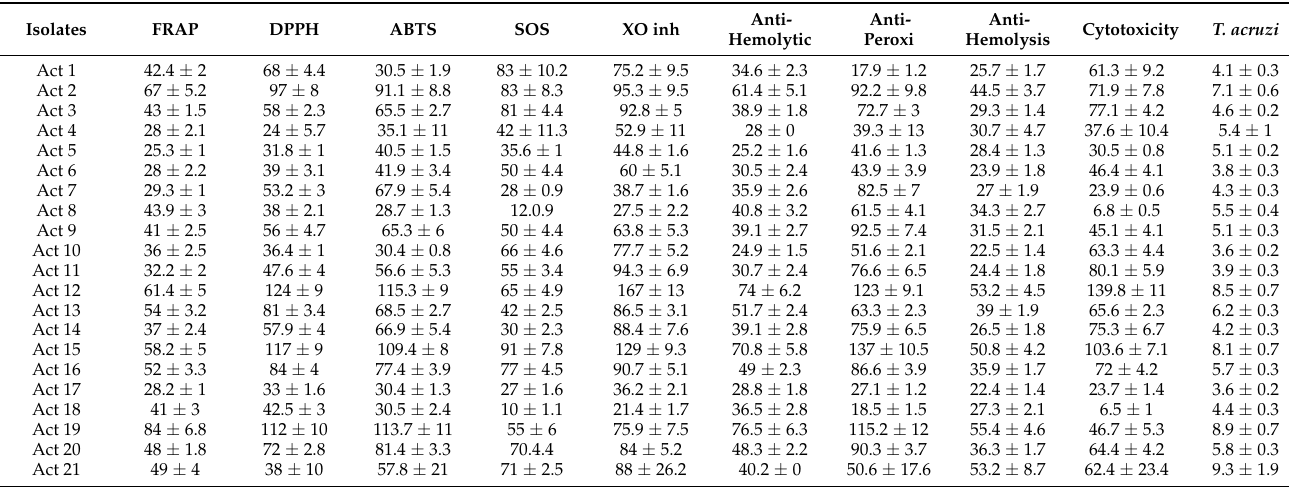
Table 2. The antioxidant, anti-hemolytic, cytotoxicity and antiprotozoal activity of 21 actinobacterial isolates. Data are represented by the means of at least 3 replicates ± standard deviations (SD).